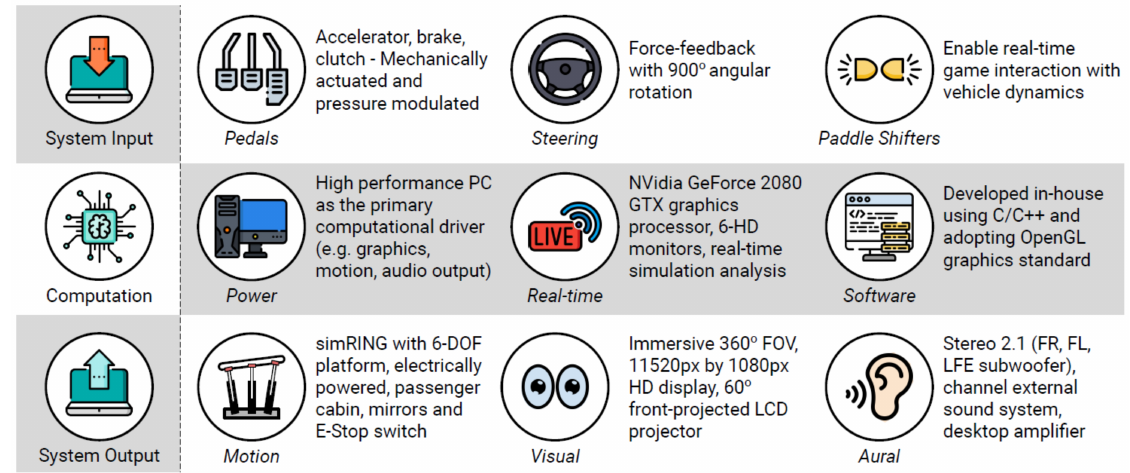
Figure 2. Input/output (I/O) rendering components for game-based learning (GBL) in engineering dynamics